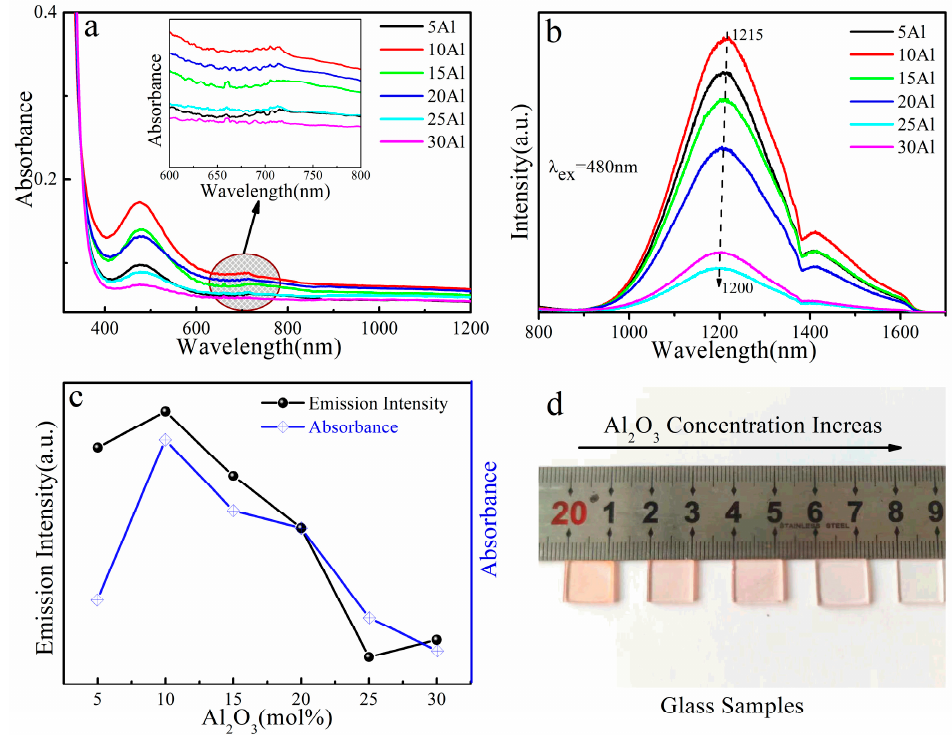
Figure 1. ( a ) Transmission spectra of (69-x) SiO 2 -30CaO-xAl 2 O 3 -1Bi 2 O 3 glasses. The inset shows their transmission spectra in the range from 600 nm to 800 nm. ( b ) PL spectra of (69-x) SiO 2 -30CaO-xAl 2 O 3 -1Bi 2 O 3 glass samples excited by a 480 nm LD. ( c ) Dependencies of emission intensity and transmittance on Al 2 O 3 concentration. ( d ) The photo of (69-x) SiO 2 -30CaO-xAl 2 O 3 -1Bi 2 O 3 glass samples.